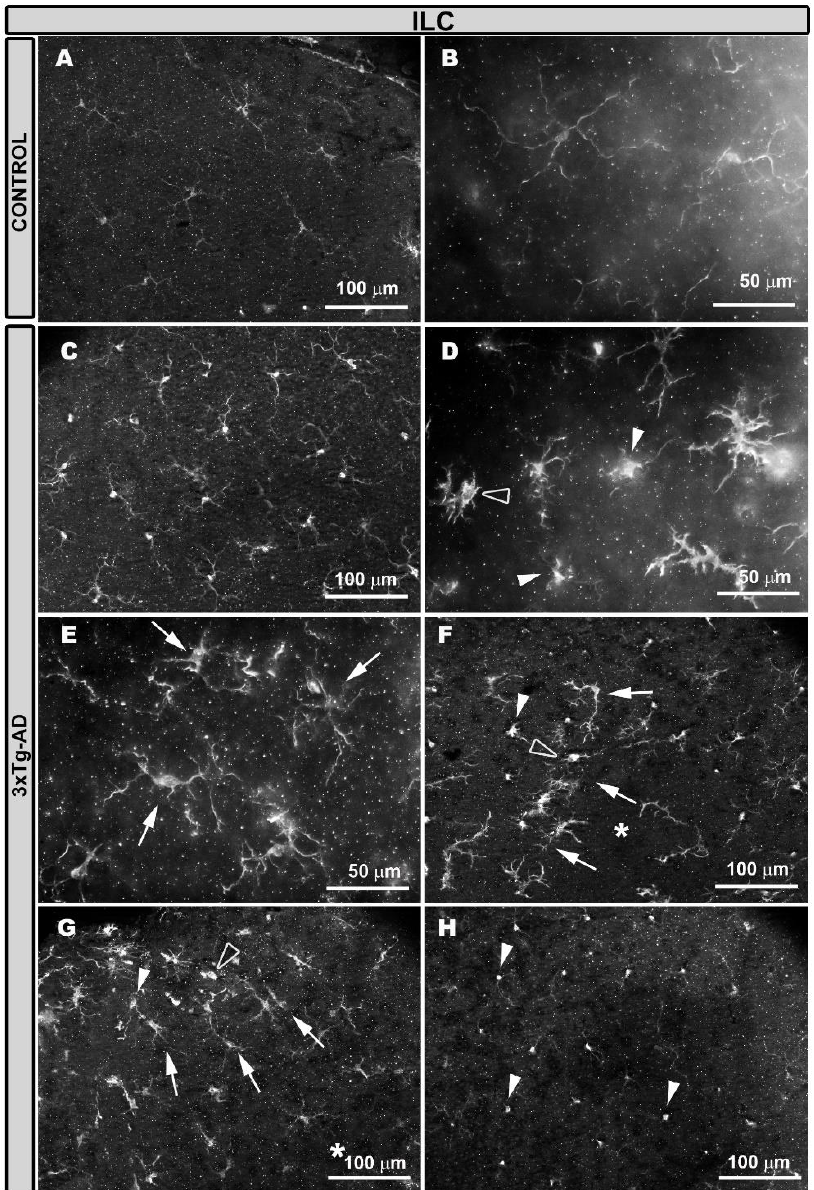
Figure 2. Iba-1 + cells in the inner retinal layer complex (ILC). Retinal whole-mount labelled with anti-Iba-1. In the age-matched control animals’ eyes ( A , B ), most of the Iba-1 + cells had a ramified appearance and formed a regular mosaic-like plexus through the retina. In 3xTg-AD animals ( C – H ), the Iba-1 + cells thickened, and their processes were retracted ( C , D ). In these retinal layers, the mosaic-like plexus was not homogeneous ( D – G ), and there were zones of cellular grouping (arrows) in a circular shape ( E ) or in rows ( F , G ). Areas without cells were also found (*). In the areas of cell grouping, amoeboid type cells (hollow arrowhead) and vertically arranged cells (white arrowhead) were observed; the latter were also found in other areas of the retina, forming large extensions (white arrowhead in H ). The ILC is constituted by the inner plexiform layer and the nerve fiber layer–ganglion cell layer.